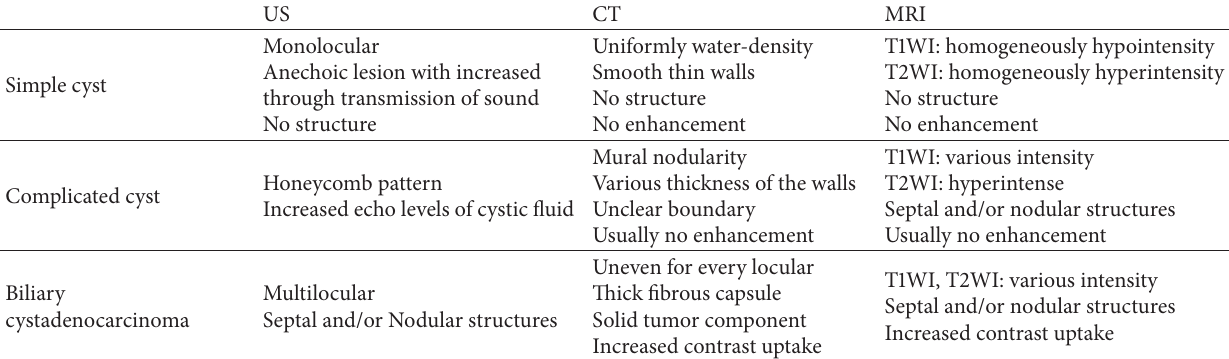
Table 1: Comparison of simple cyst, and complicated cyst and biliary cystadenocarcinoma.